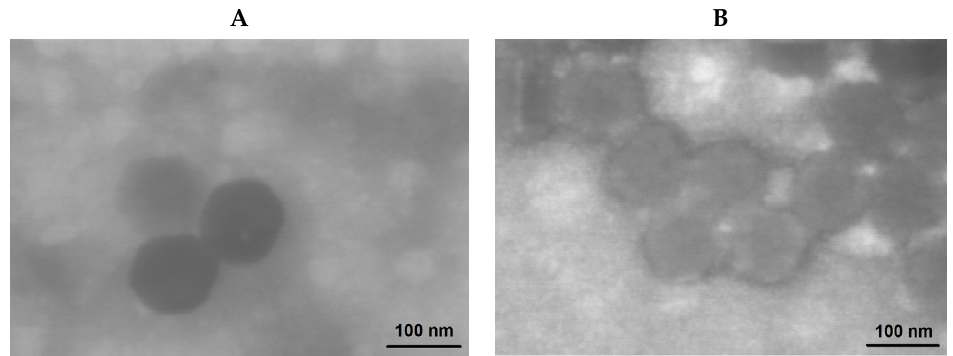
Figure 10. TEM images of PMAG- b -PChMA ( A ) and PVSAA- b -PChMA- b -PVSAA (sample #h2) ( B ) nanoparticles.